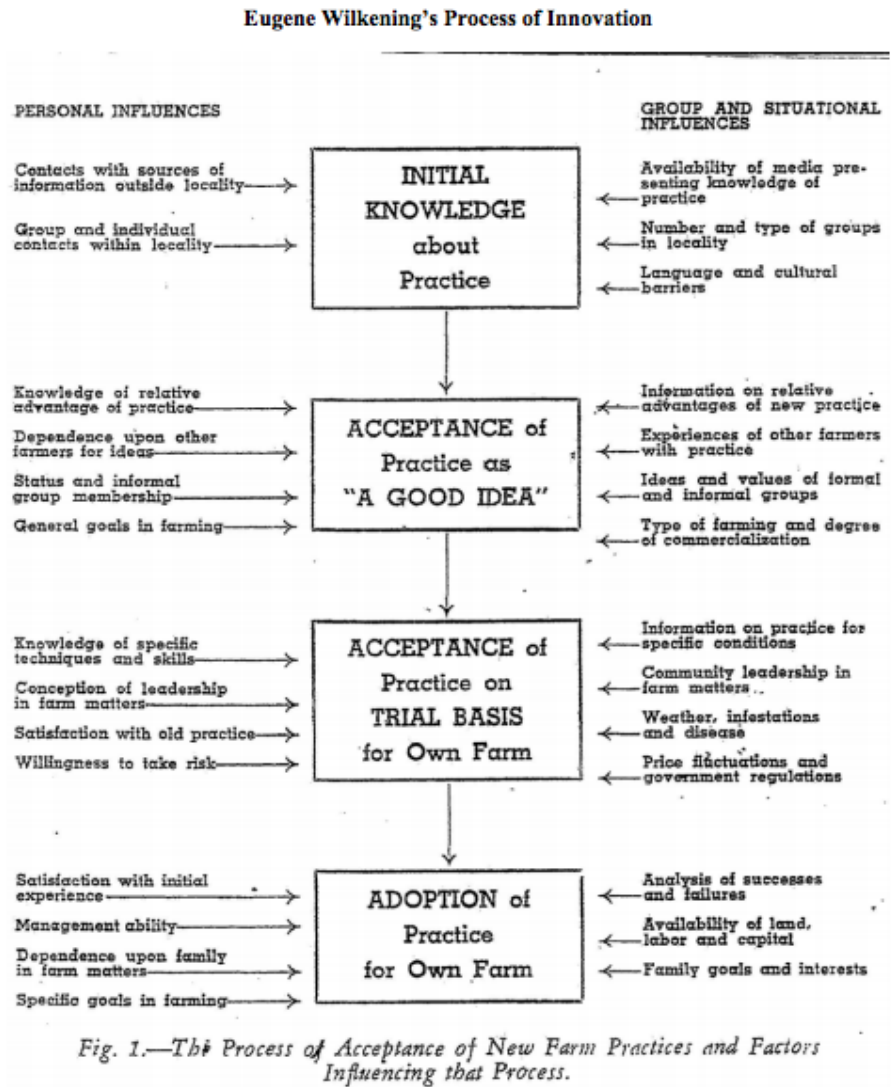
Fig. 1. Wilkening, E. A. (1953), Adoption of Improved Farm Practices As Related to Family Factors, AES Research Bulletin no. 183, University of Wisconsin,